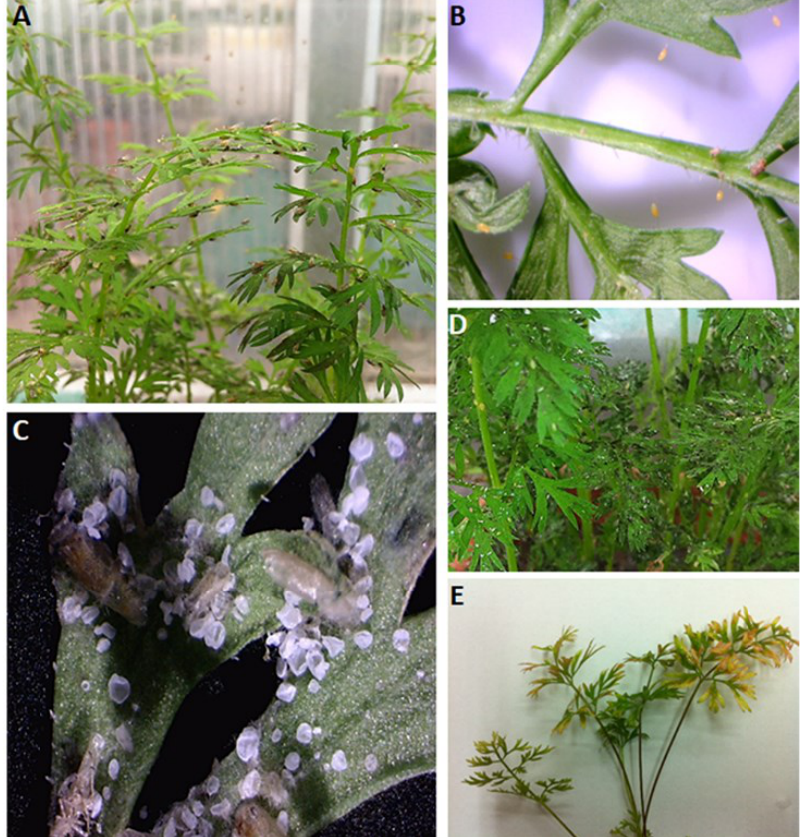
Figure 1. Carrot psyllid Bactericera trigonica population on a carrot plant ( A ), eggs laid in leaves and stems ( B ), sugary secretions from adult carrot psyllids on carrot leaves ( C , D ) and symptoms of leaf yellowing on a carrot seedling after infection with Liberibacter solanacearum ( E ). Table 1. Diseases caused by Liberibacter species, their hosts, and